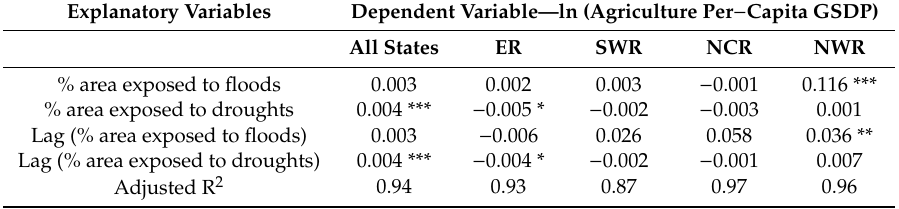
Table 5. Regressions on flood and drought-a ff ected areas with agriculture per-capita GSDP.